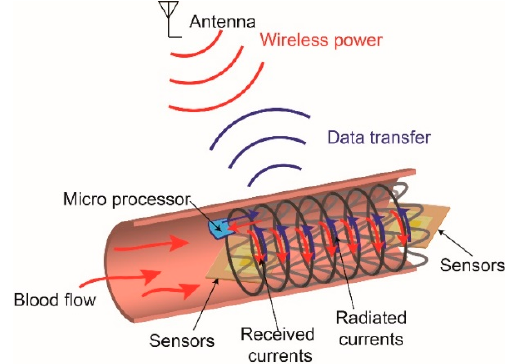
Figure 1. Illustration of a smart stent wherein the entire stent acts as an antenna for transferring biomedical information measured via integrated sensors to the external monitoring system.